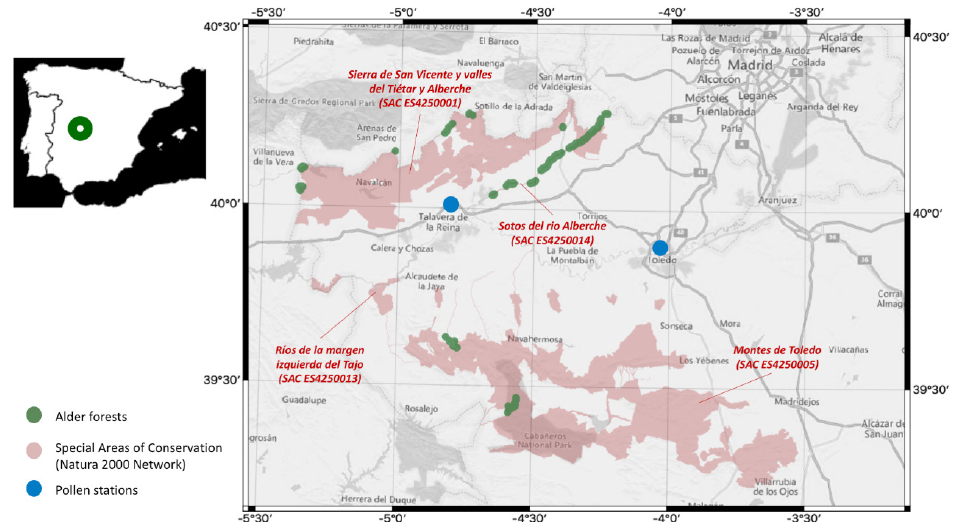
Figure 2. Location of the study area. Green points represent alder forests and red polygons, the study area belonging to the four Special Areas of Conservation (SACs) from the Network Natura 2000 in central Spain. Source of the base map: GoogleMaps 